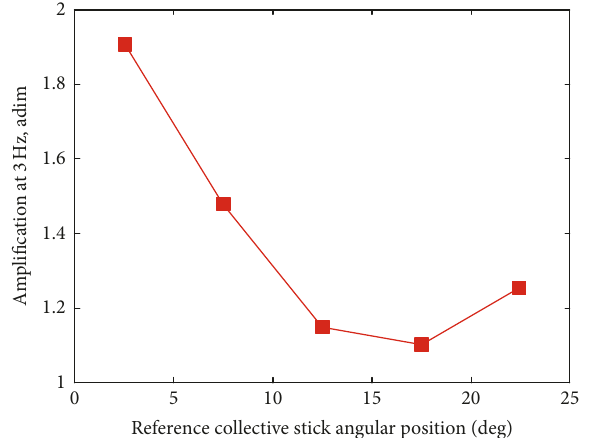
Figure 4: Influence of reference arm position on pilot transfer function.